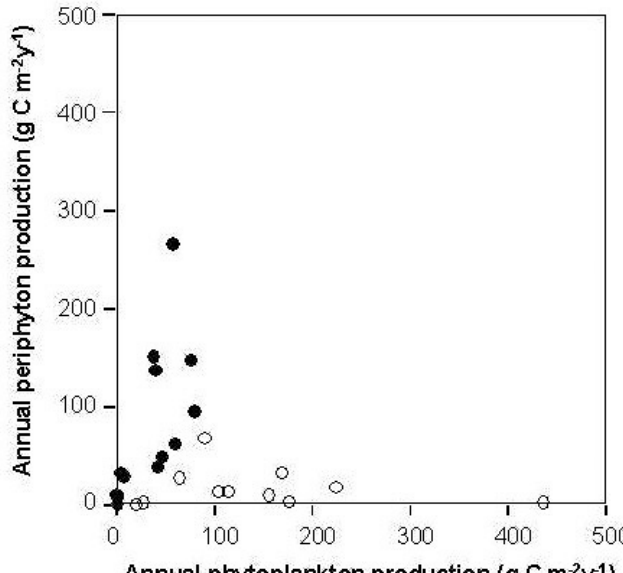
FIGURE 4. Areal whole-lake periphyton productivity is a unimodal function of phytoplankton productivity. Data are from Table 1. Only lakes for which periphyton productivity was measured on all substrata were included (Lakes 239 and 240 were omitted). Closed symbols are lakes for which periphyton productivity > phytoplankton